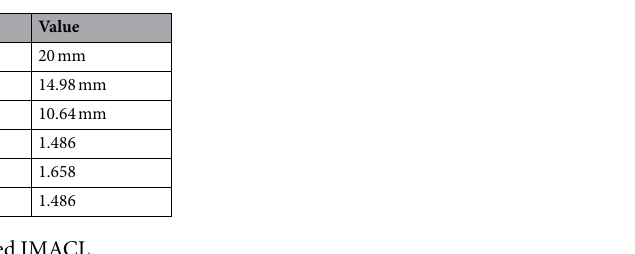
Table 1. Specification of implemented IMACL.